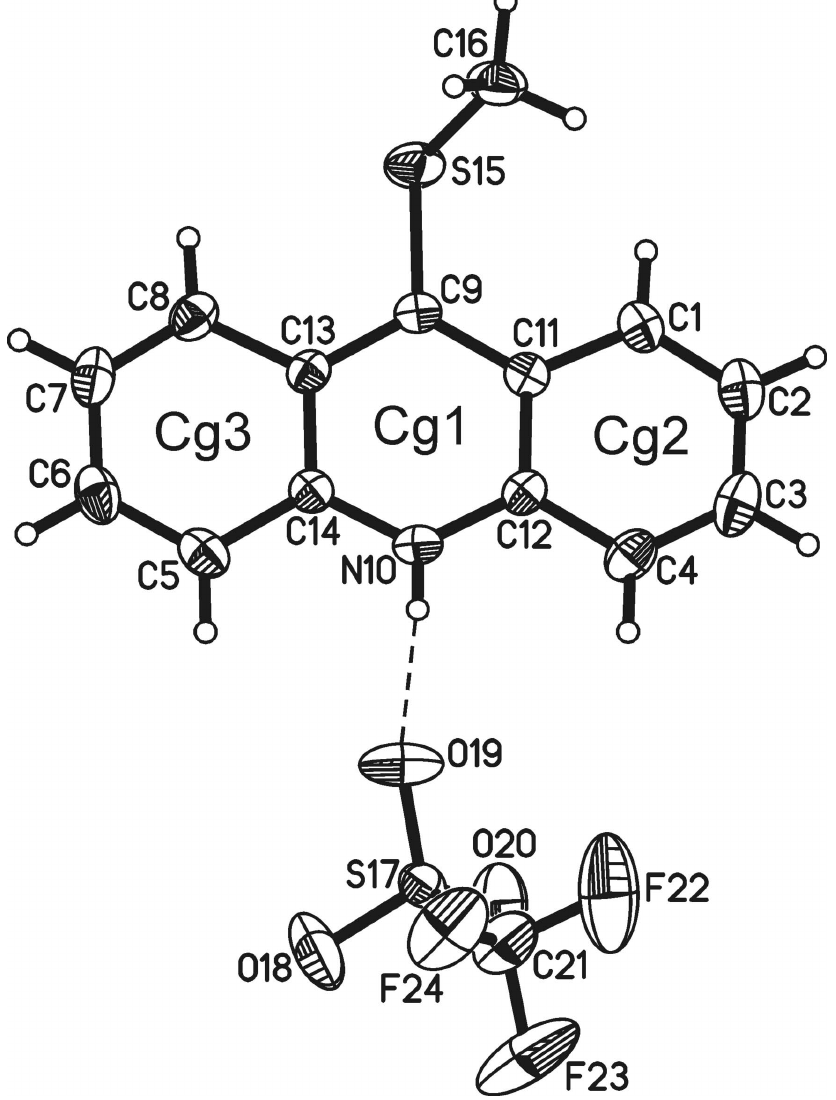
The molecular structure of the title compound showing the atom-labeling scheme. Displacement ellipsoids are drawn at the 25% probability level and H atoms are shown as small spheres of arbitrary radius. The N10–H10···O19 hydrogen bond is represented by a dashed line. Cg 1, Cg 2 and Cg 3 denote the ring